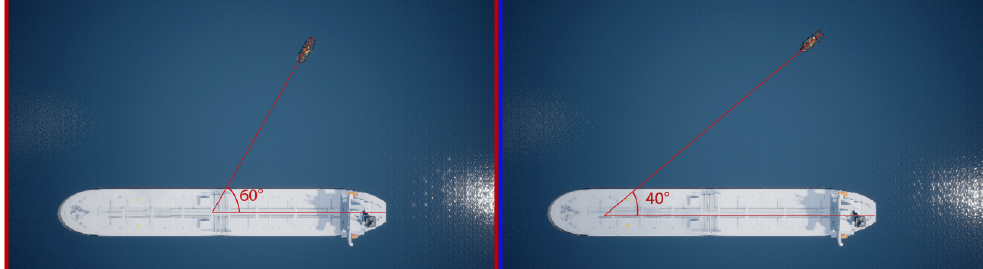
Figure 6. Examples of collision angle test between two vessels on a collision course. ( Left ) Highlights in red represent the test with vessels experiencing a collision angle of 60 ◦ . ( Right ) Highlights in blue represent the two vessels experiencing a collision angle of 40 ◦ .